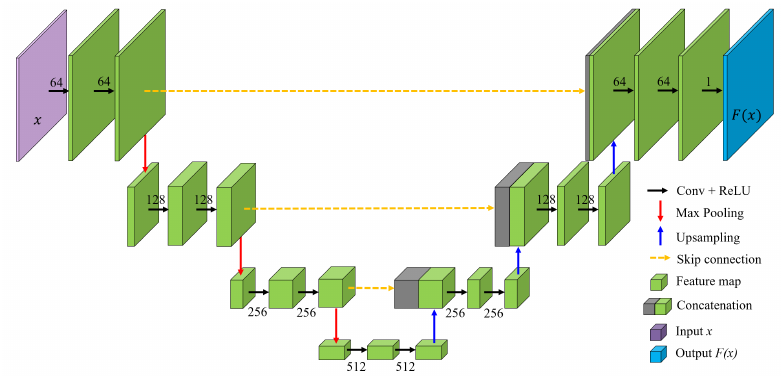
Figure 2. U-Net-like architecture utilized for TanDEM-X image classification. The numbers close to the convolutional layers identify the number of kernels. All kernels have size 3 × 3 except from the last layer which is a 1 × 1